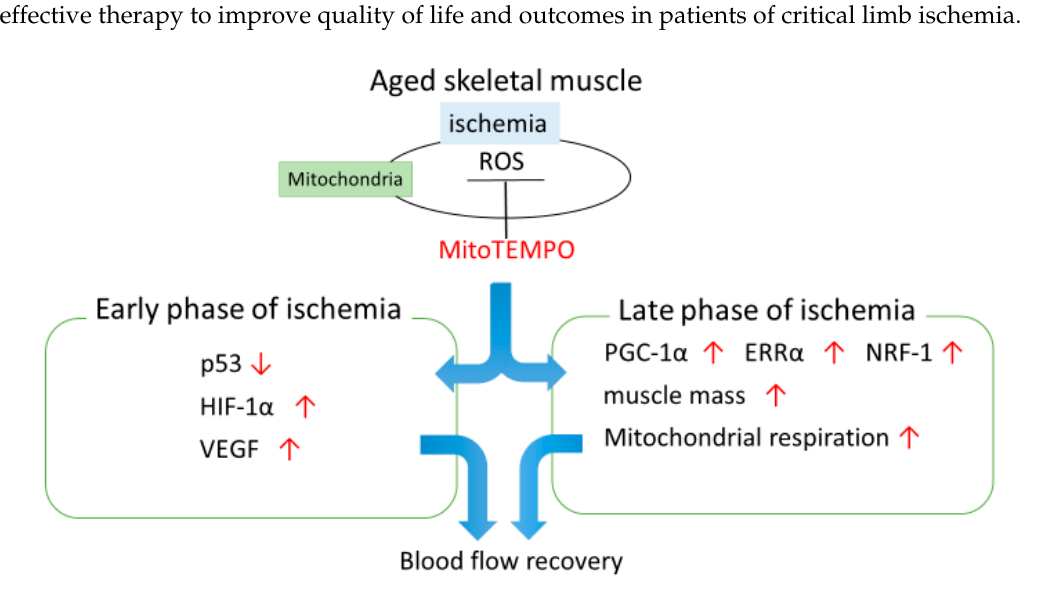
Figure 8. The role of mitochondrial ROS in the regulation of blood flow recovery with ischemia in aging. In aged muscle, mitochondrial ROS induced by ischemia impairs blood flow recovery. Mitochondrial superoxide scavenging improves blood flow related to downregulation of p53, upregulation of HIF-1 α and VEGF in the early phase of ischemia, and preservation of PGC-1 α , NRF-1, and ERR α in the late phase of ischemia. Scavenging of mitochondrial superoxide with MitoTEMPO is an effective means to preserve blood flow following limb ischemia. Red arrows pointing upwards indicate increase, pointing down indicate decrease of the protein expression, muscle mass and mitochondrial respiration in MitoTEMPO-treated aged muscle compared to non-treated one.